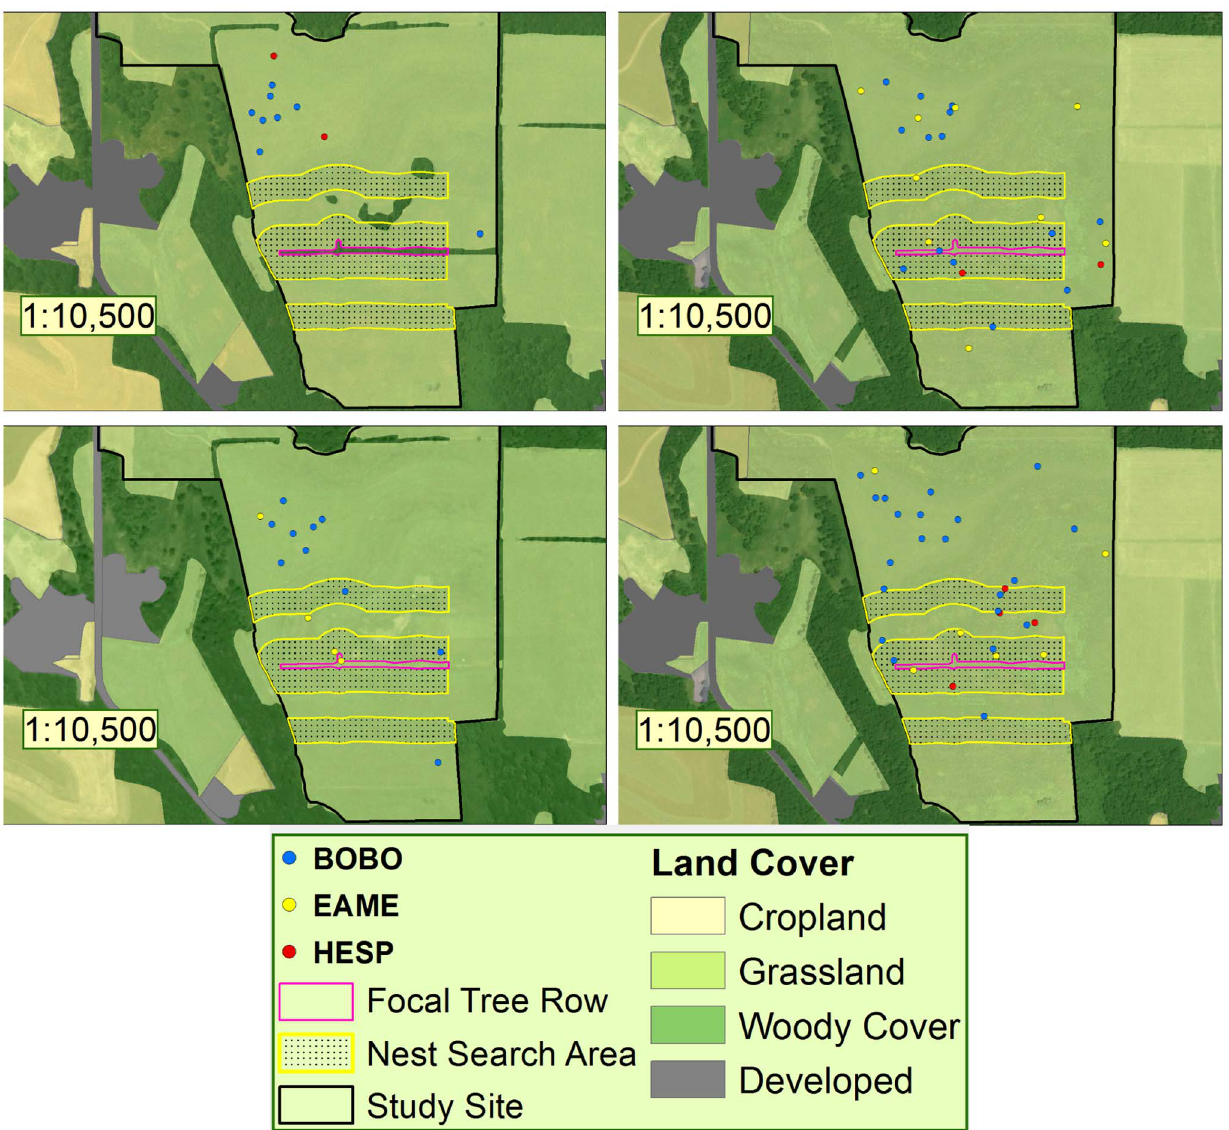
Figure 2. Annual maps of nest dispersion. Nests of the 3 focal species relative to the focal tree row, edge, and interior habitat at a tree row removal site in southwest Wisconsin. More nests occurred in the tree row edge area following the removal of woody vegetation. Dots refer to nest locations by species, with: blue for bobolink, yellow for Eastern meadowlark, and red for Henslow’s sparrow. doi:10.1371/journal.pone.0059151.g002 PLOS ONE |